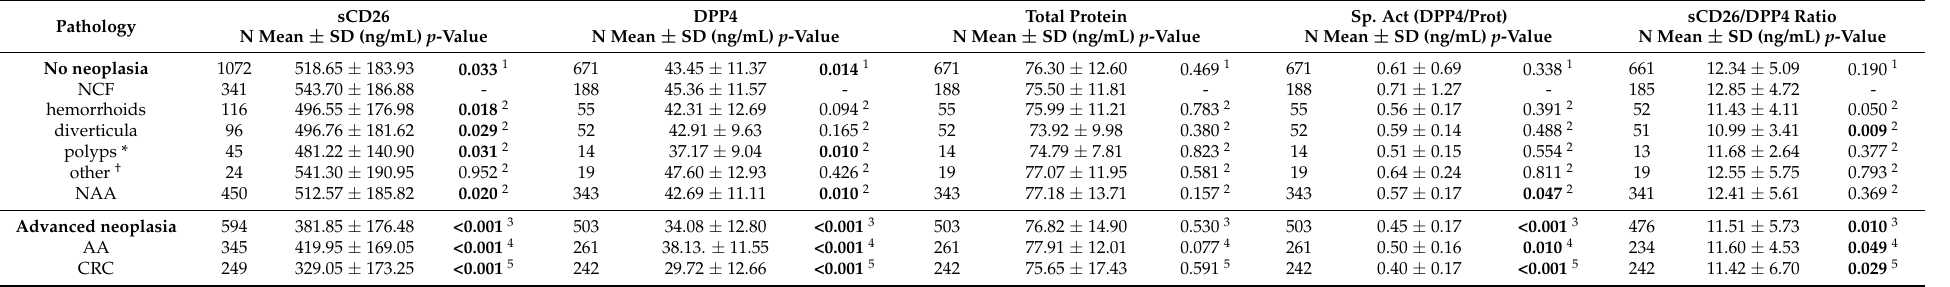
p -value: 1 Student’s t -test for comparison of sex groups; 2 ANOVA for comparison of age groups; 3 Student’s t -test for comparison of young vs. middle-aged; 4 Student’s t -test for comparison of young vs. older-aged. Table 3. Levels of serum sCD26 and DPP-IV activity according to colonoscopy